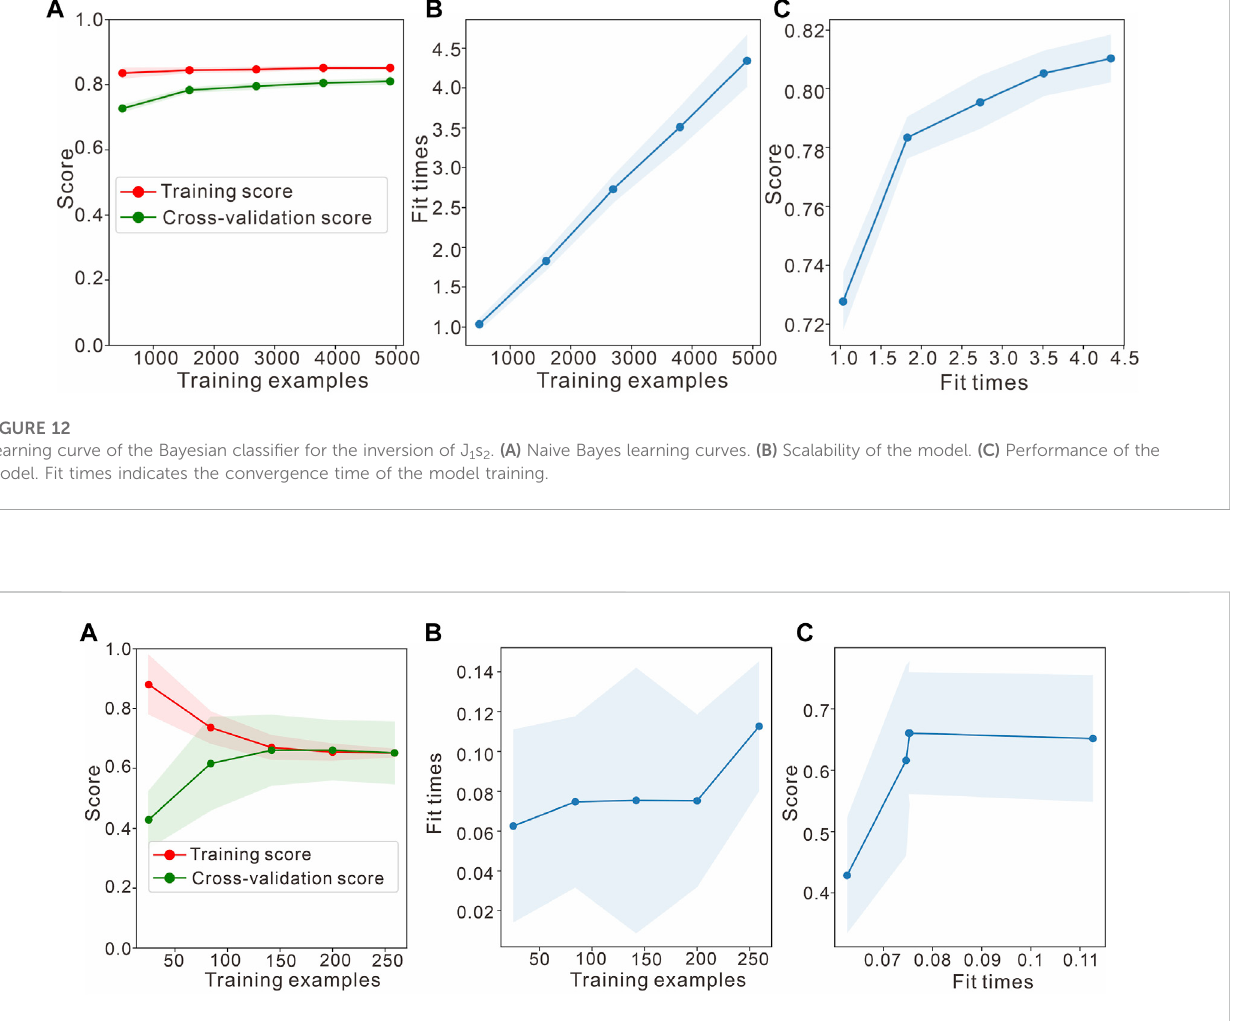
FIGURE 13 Learning curve of the improved Naive Bayesian classi fi er for the inversion of J 1 s 2 . (A) Learning curves of improved Bayes. (B) Scalability of the model. (C) Performance of the